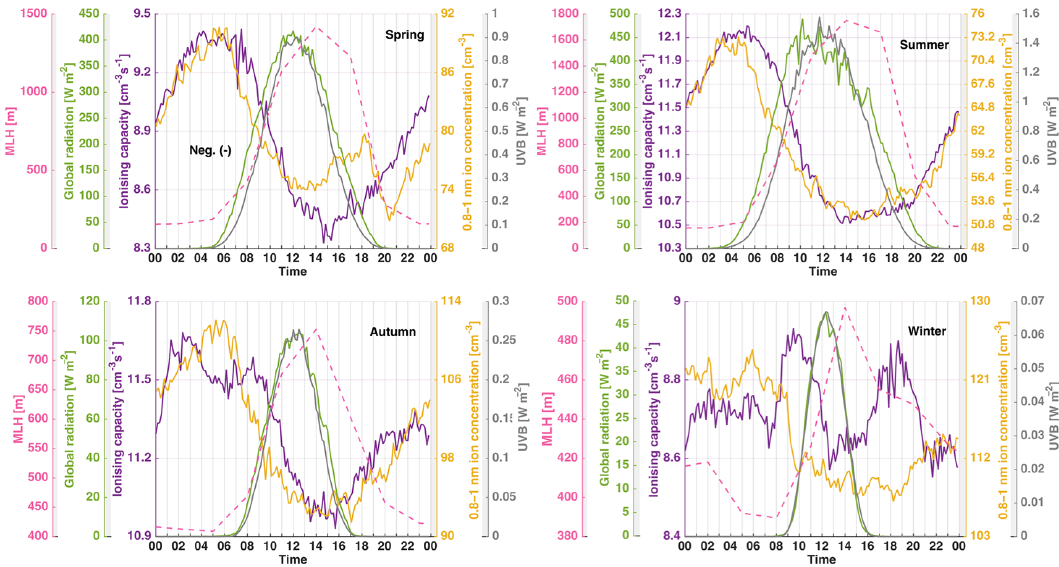
Figure 11. Diurnal patterns in median 0.8–1nm negative and positive ion concentrations, ionising capacities, global and UVB radiation intensities as well as modelled mixing layer heights (MLH) in different seasons over